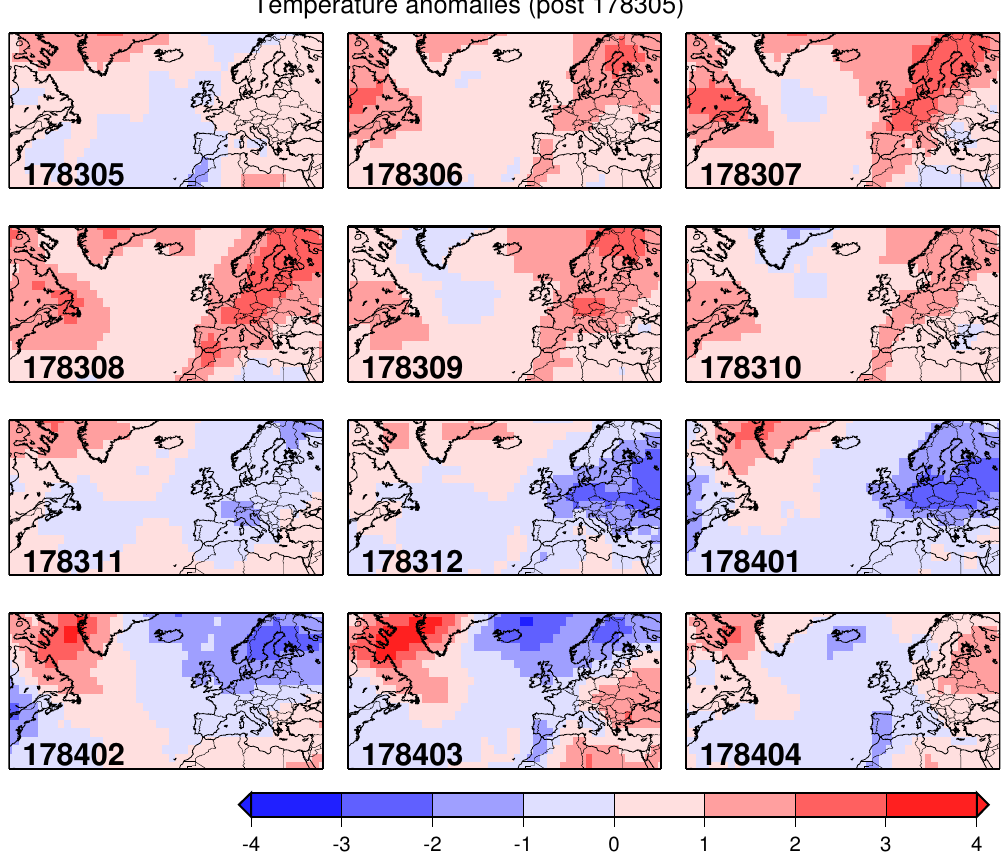
Fig. 4. Median of 20 surface air temperature anomaly reconstructions (in K) with respect to 1971–2000, between May 1783 and April 1784. The months are indicated in the lower left corners of the panels as 10 2 y + m , where y and m are respectively the year and the month.